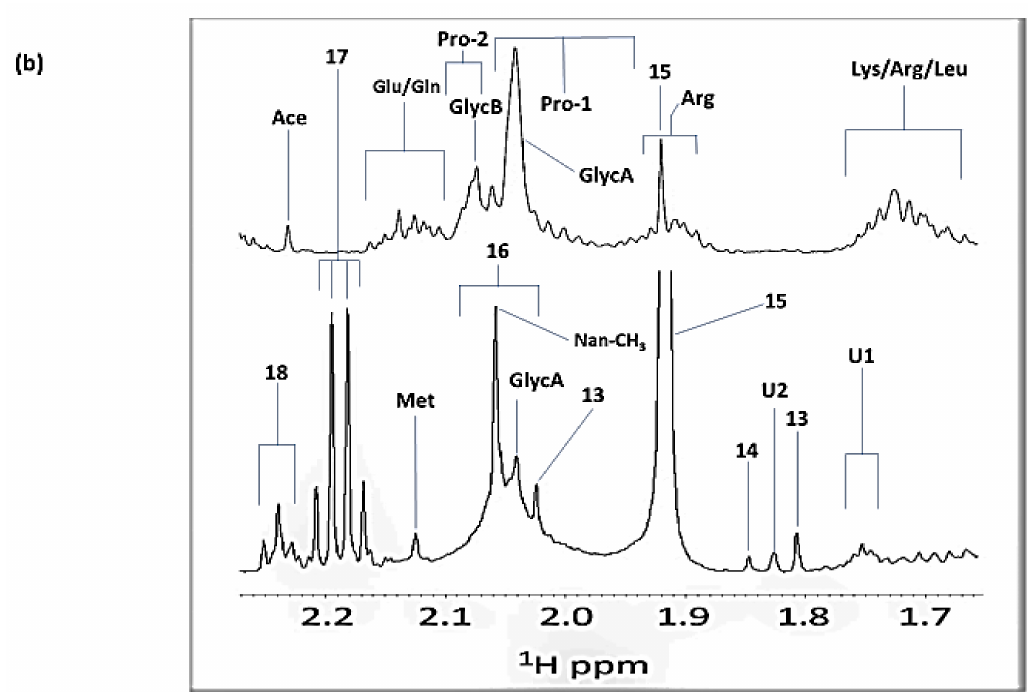
Figure 4. 1 H NMR Analysis of APP Side-Chain N-Acetylsugar Residues Present in Human Saliva and Blood Plasma. ( a ) Expanded 1.65–2.30 ppm region of the 1 H NMR WASTED-II spectral profile of healthy human blood plasma, showing potential interferences with the quantification of macro- molecular GlycA and GlycB species arising from the free amino acids proline and glutamate, and low-molecular-mass N-acetylsugar and possible N-acetylamino acid metabolites. The red vertical line indicates the chemical shift value of free N-acetylglucosamine at δ = 2.044 ppm, which is very similar to that of the much broader GlycA signal. ( b ) Expanded 1.65–2.27 ppm regions of the 1 H NMR WASTED-II spectra of human blood plasma (top) and WMSS (bottom) samples collected from healthy human participants to allow comparative evaluations of their acetamido-CH 3 resonances, which arise from both low- and high-molecular-mass biomolecules in these biofluids. Typical spectra are shown. Spectra were recorded on a Jeol JNM-ECZ600R/S1 600 MHz spectrometer operating at frequency of 600.17 MHz for 1 H, at a probe operating temperature of 25 ◦ C. Assignment abbreviations: As Table 1, with Lys-1 and -2, lysine- γ - and β -CH 2 groups, respectively; Pro-1 and -2, proline- γ - and β -CH 2 groups, respectively; Glu-1 and -2, glutamate- β -CH 2 resonances; Hpro, hydroxyproline- β -CH 2 ; Gln, glutamine- β -CH 2 ; Met, methionine-S-CH 3 ; Ace, acetone-CH 3 ; Nan-CH 3 , N-acetylneuraminate-CH 3 ; S, S1, U and U1, unidentified resonances, those in the plasma profile shown in ( a ) may being ascrib- able to further 1 H NMR-distinguishable -NHCOCH 3 functions, with S1 possibly representing